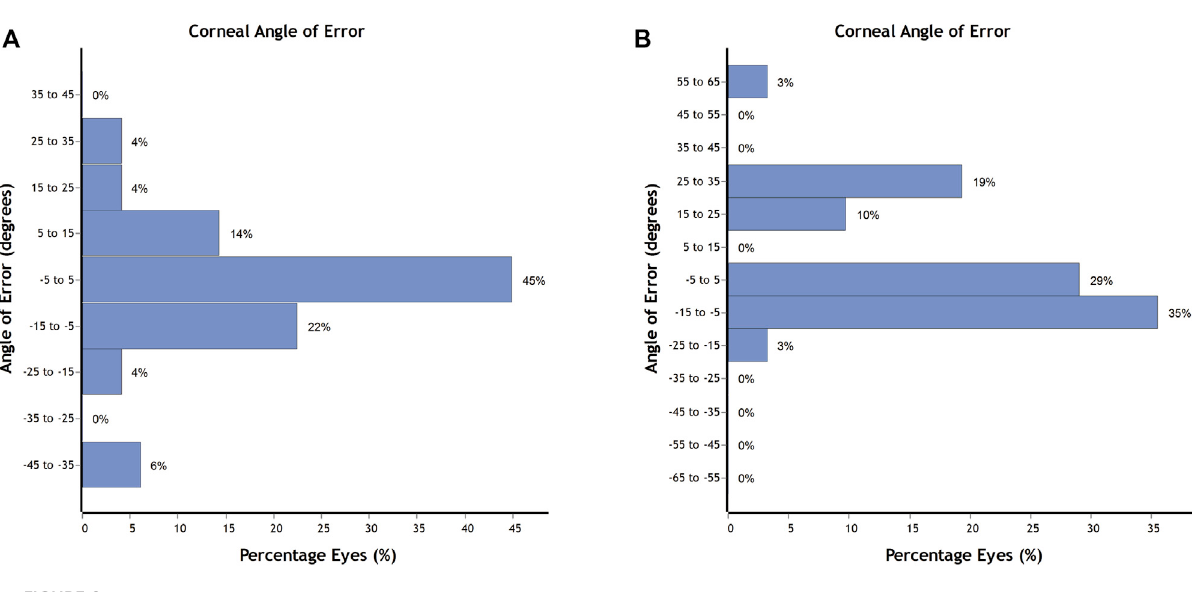
Frontiers in Cell and Developmental